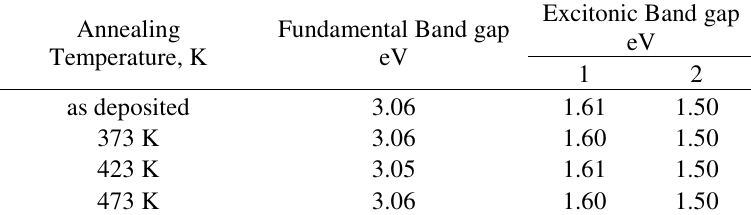
Table 1. Variation in band gap energy with annealing temperature